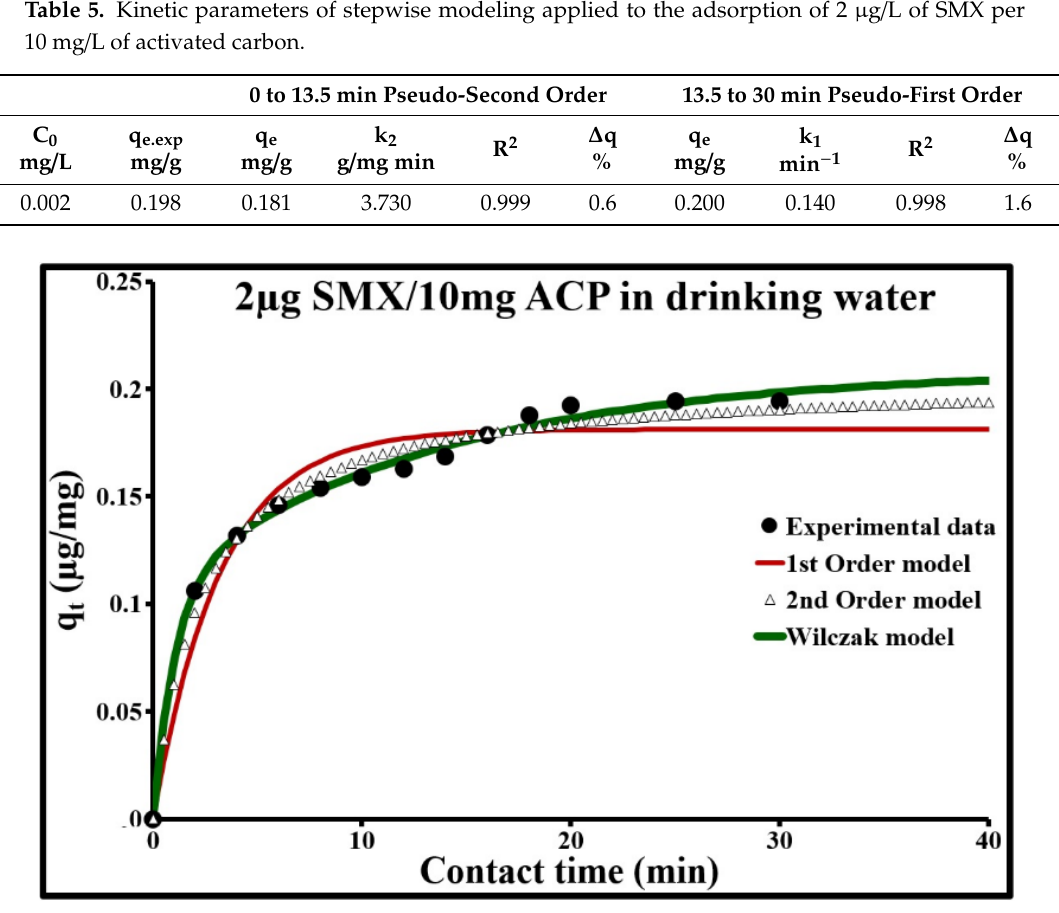
Figure 7. Comparison of adsorption kinetic models at 293 K for 2 µg/L of SMX and 10 mg/L of ACP Norit SA Super in drinking water.